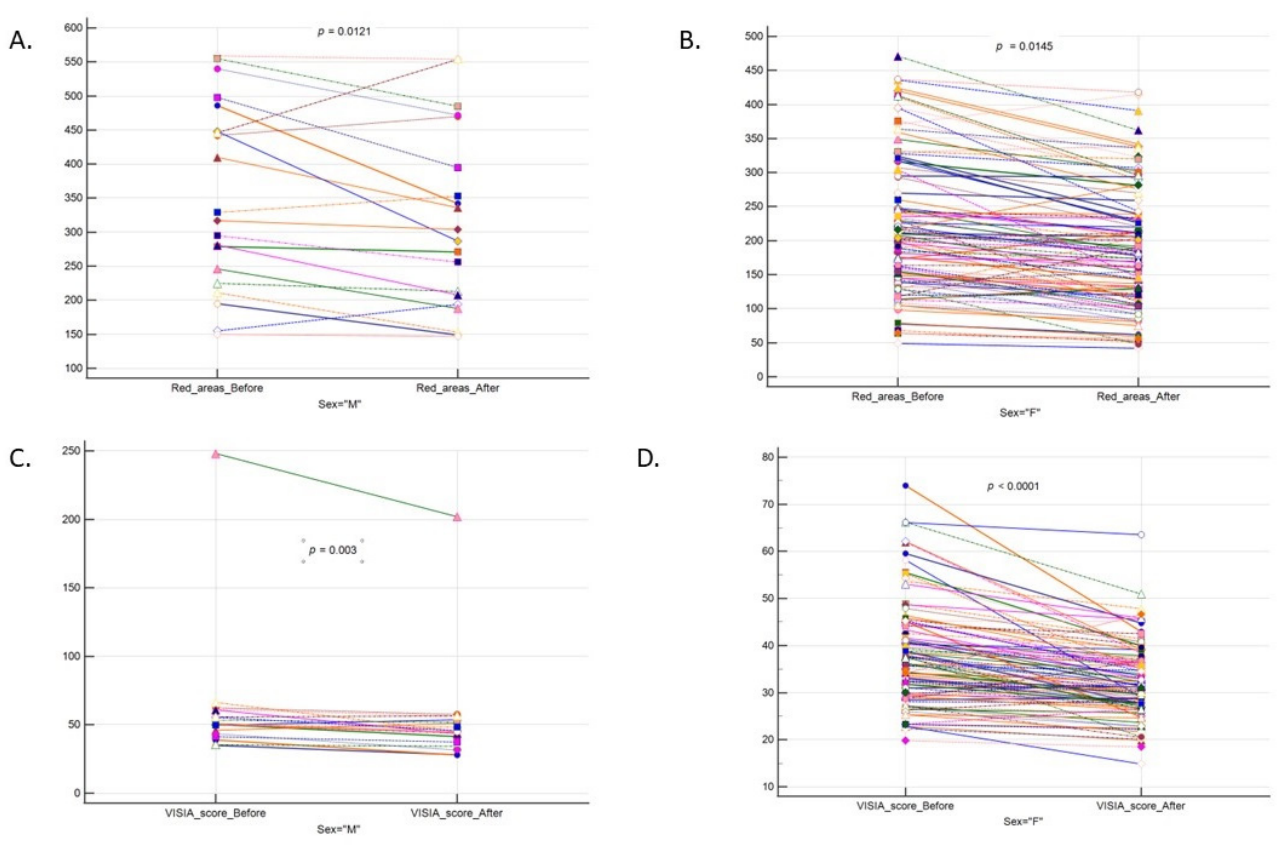
Figure 1. Laser therapy efficacy regarding red number areas in ( A ). Males, ( B ). Females and VISIA score in ( C ). Males and ( D ). Females. Note, VISIA score in men after excluding an outlier; p = 0.0005. Laser treatment efficacy expressed as delta scores for both outcomes that were analysed were not significantly influenced by skin phototype ( p > 0.05; Figure 2).